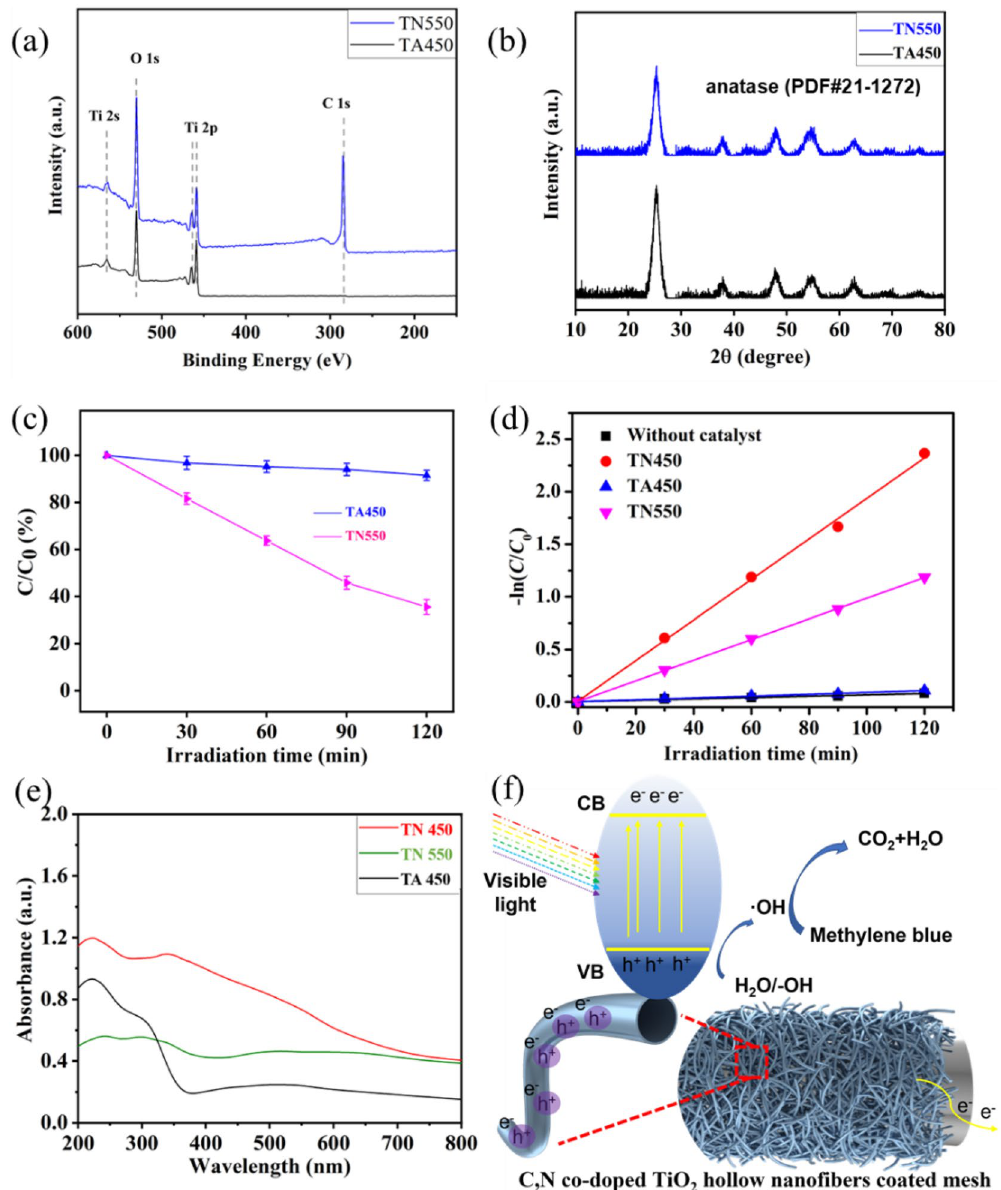
Figure 8. ( a ) The XPS spectrum of TA450 coated mesh and TN550 coated mesh; ( b ) The XRD spectrum of TN550 and TA450; ( c ) the photocatalytic performance of TA450 and TN550 coated mesh under visible light; ( d ) variations of − ln( C / C 0 ) versus irradiation time with neat mesh, TN450, TA450, and TN550 coated meshes under visible light; ( e ) the UV–Vis diffuse reflectance spectrum of TN450, TN550 and TA450 coated mesh; ( f ) Possible photocatalytic degradation mechanism of methylene blue by the TN450 coated